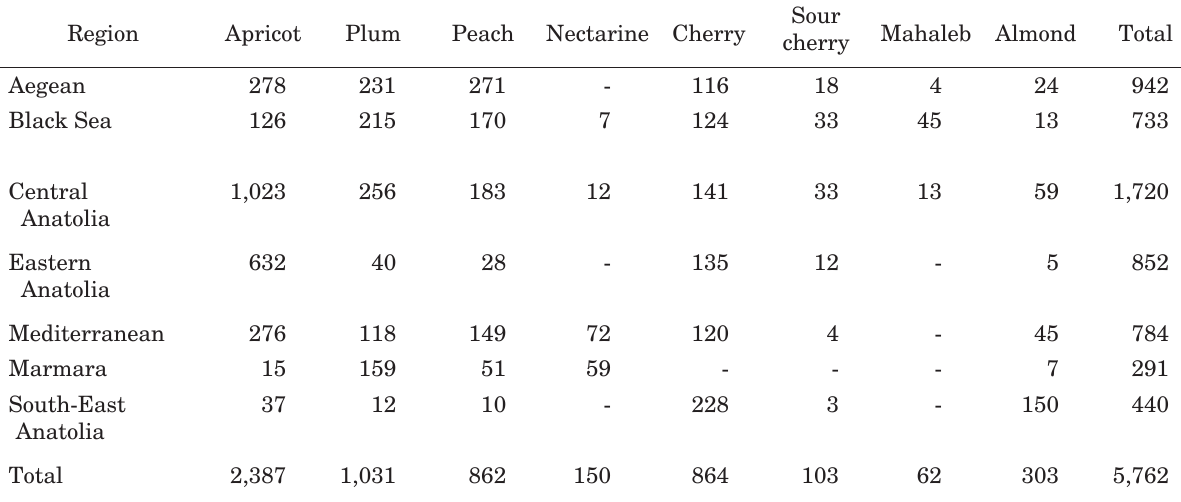
Table 2. Prunus species inspected in surveyed areas. Region Apricot Plum